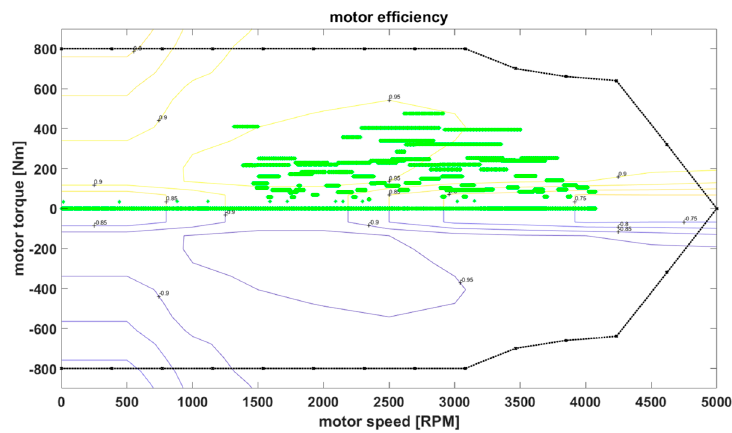
Figure 12. Efficiency points of the HEHV (rule-based) electric motor.